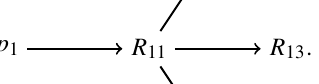
Fig. 17 The subregion R 15